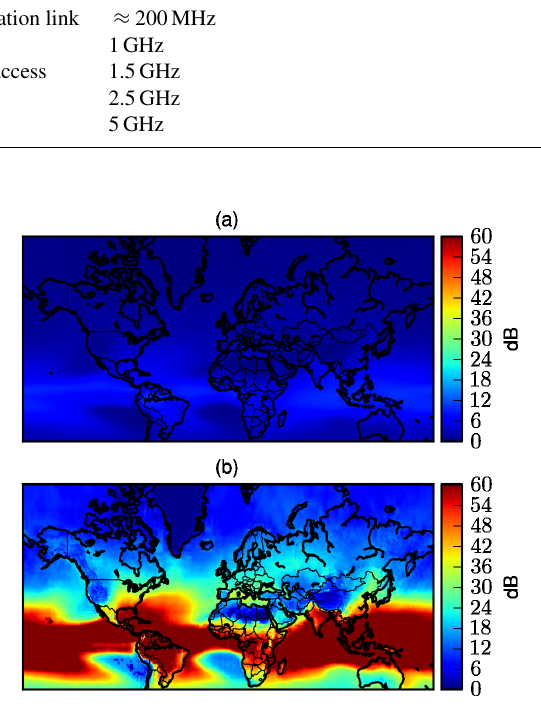
Figure 1. Attenuation that exceeded 0.1% of the time computed from ITU-R P.618-13 (2017) for a link with a geostationary satellite at 35 ◦ of elevation at 12GHz (a) and 50GHz (b)